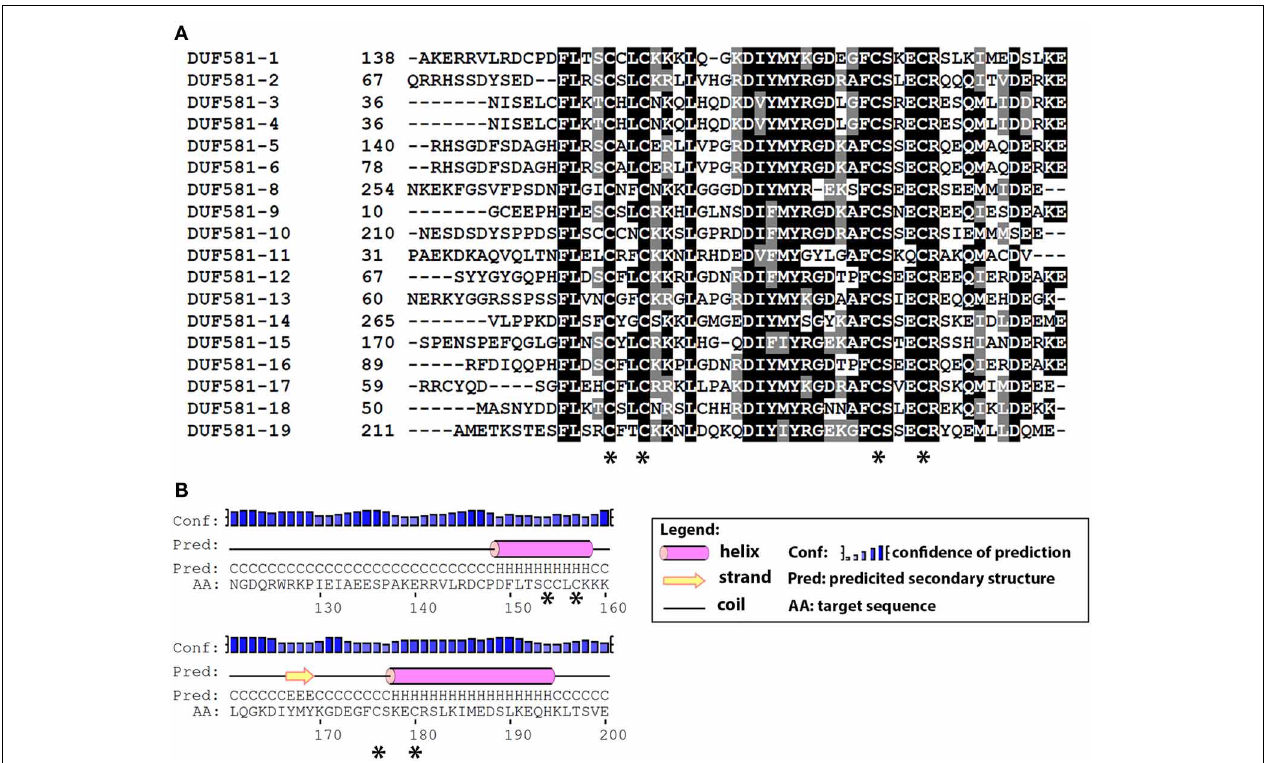
FIGURE 1 | Sequence alignment and predicted topology of the DUF581. (A) Multiple alignment of the DUF581 from DUF581 containing proteins of Arabidopsis . Sequences were aligned using CLUSTALW and displayed by using BOXSHADE (www.ch.embnet.org/software/BOX_form.html). The